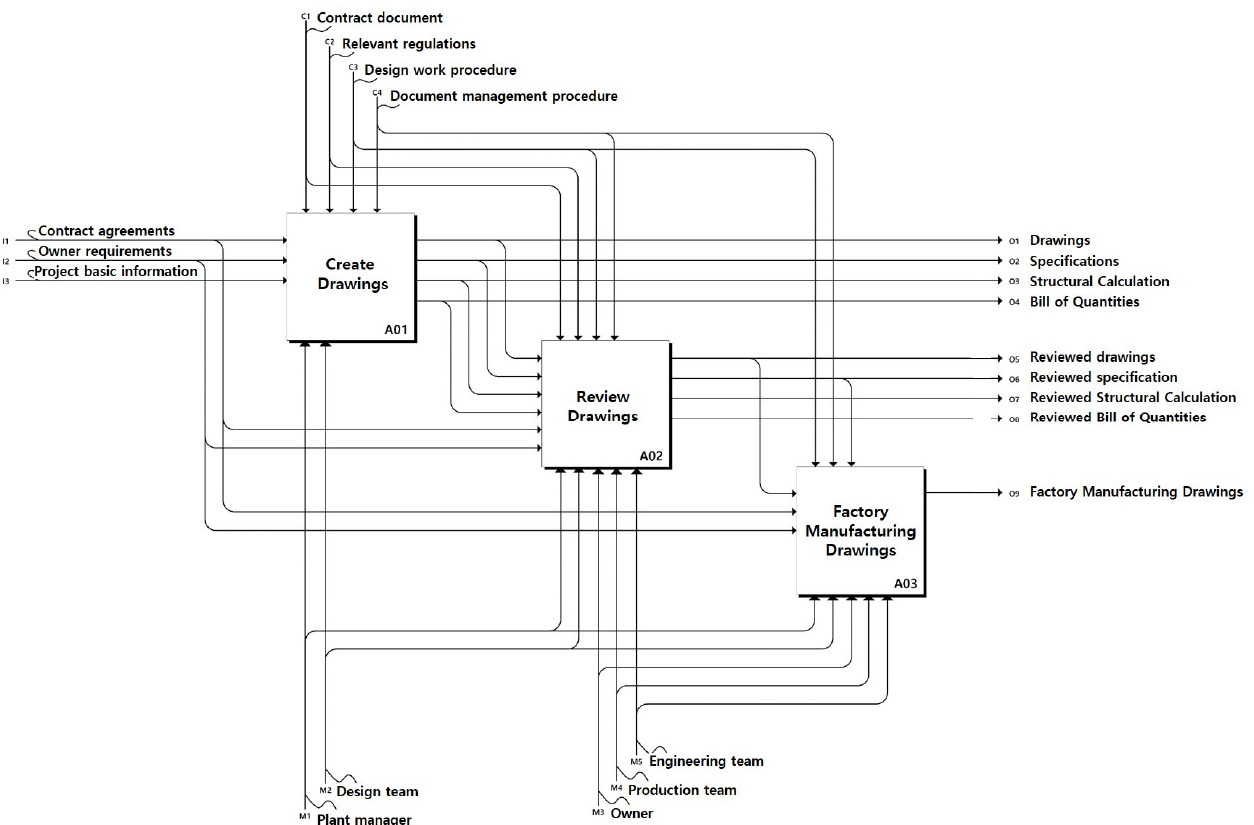
Figure 3. IDEF0 modeling results for quality management in design.